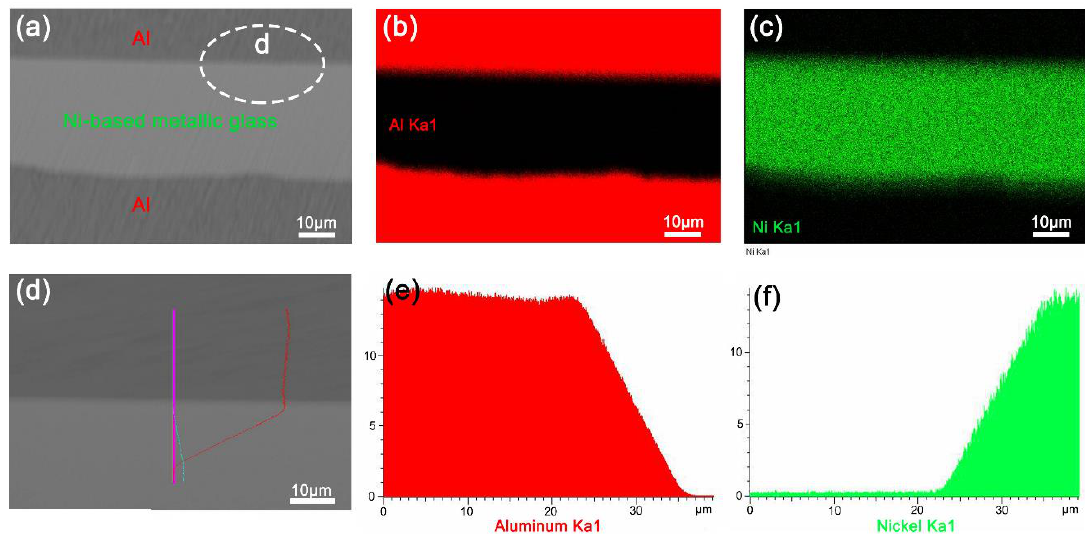
Figure 2. The cross-sectional SEM image of Al / Ni-based (MG) composites ( a ), EDS mapping analysis of Al ( b ) and Ni ( c ) elements, and EDS line analysis of Al ( e ) and Ni ( f ) elements along the pink line of the cross-sectional SEM image ( d ).